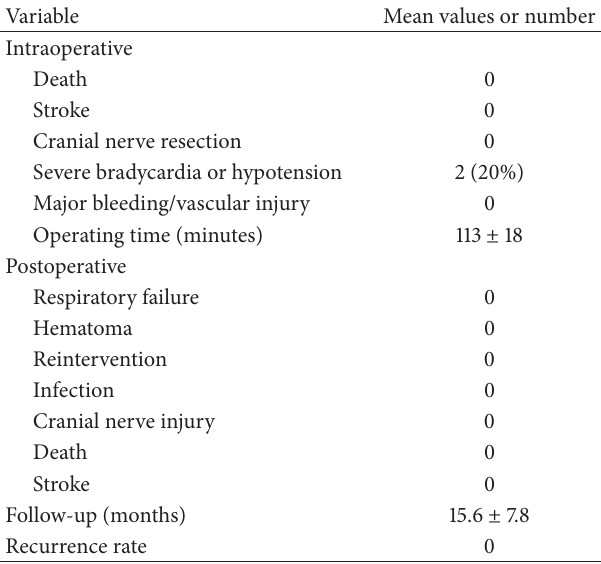
Table 3: Outcomes, complications, and follow-up of